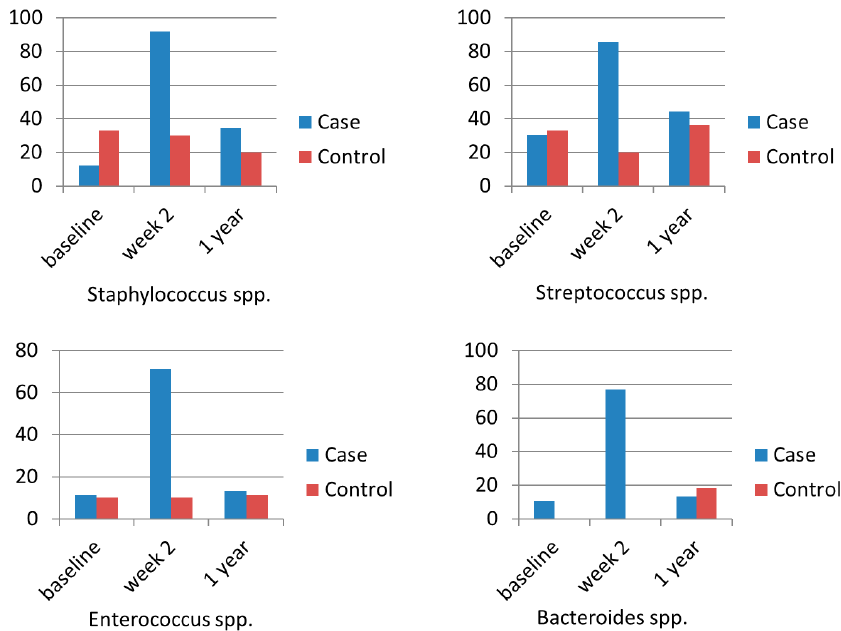
Figure 6. The impact of triple therapy on the antibiotic resistance of clarithromycin [6]